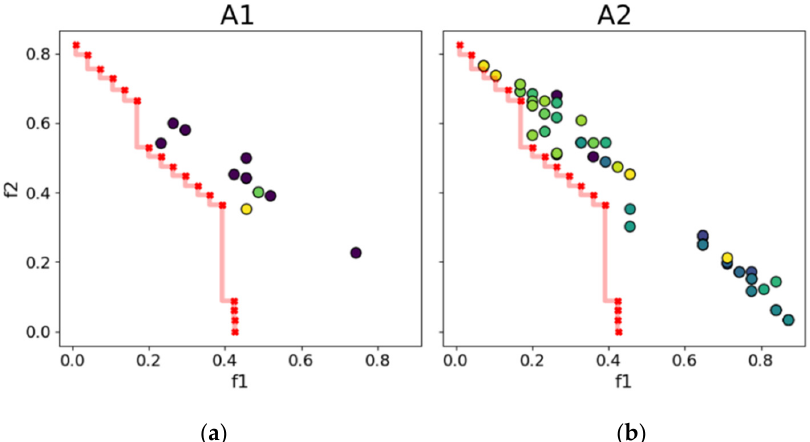
Figure 7. Difference in hypervolume between the optimal Pareto front and the Pareto front approx- imated by A1 (blue) and A2 (red) over the iteration considering Net1 ( a ) and Hanoi ( b ).